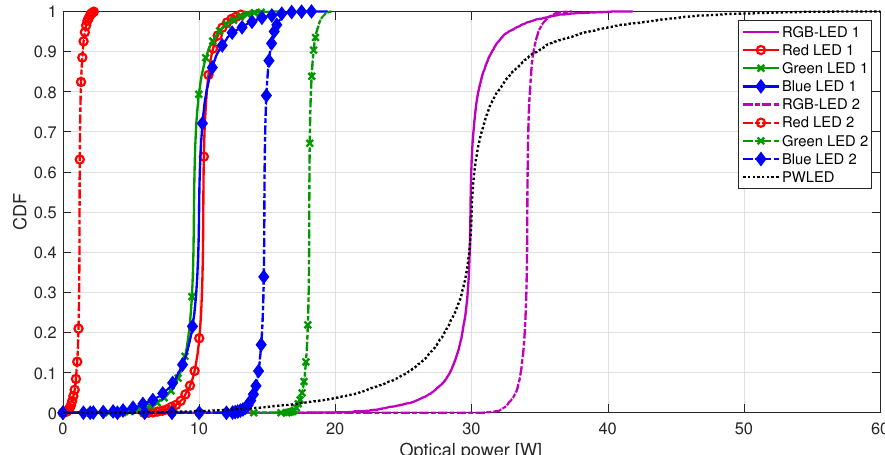
Figure 8. CDF of the instantaneous optical powers of RGB units, red LEDs, green LEDs, and blue LEDs in a system with N = 12 RGB units, and CDF of the instantaneous optical power of PWLED LEDs in a system with twelve phosphor-coated LEDs. The number of users in the system is K = 6. The CDFs have been obtained with 1000 independent realizations varying randomly the users’ positions. For each realization, the BER requirement is satisfied through the variation of the M-PAM